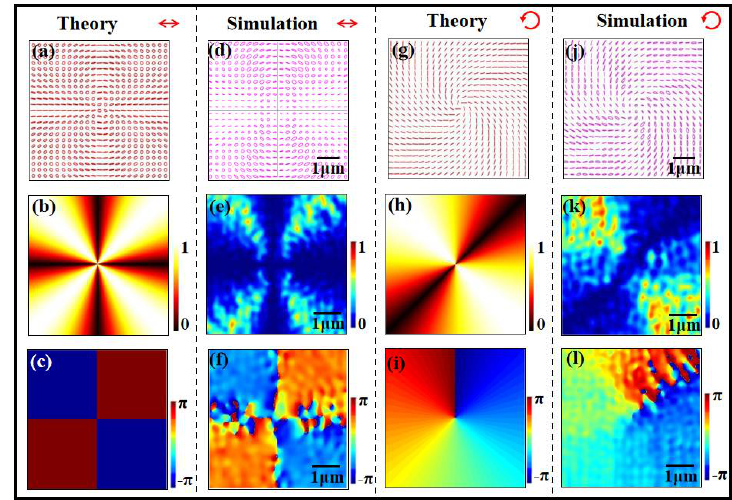
Figure 4. Theoretical and simulated polarization distributions ( a , d , g , j ), y -component intensity ( b , e , h , k ) and phase distributions ( c , f , i , l ) of highly integrated metasurface polarizer the under hori- zontal linearly polarized light and left-handed circularly polarized light illumination. The scale bar denotes 1 µm.